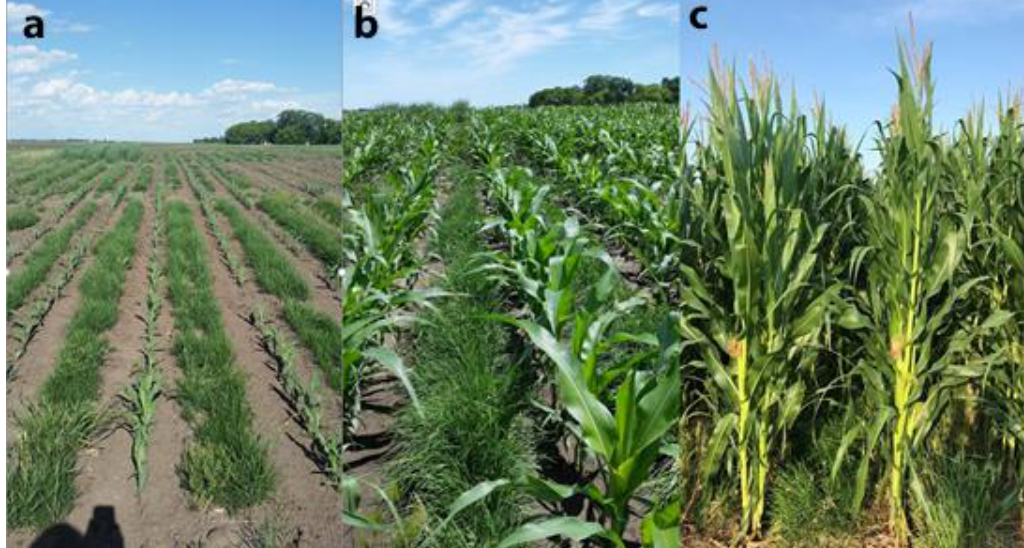
Figure 7. Maize production with Kentucky bluegrass as ground cover (( a ) 31 May, ( b ) 13 June and ( c ) 10 July 2018). Kentucky bluegrass was established in the fall of 2017. A grass-free zone was created in the spring of 2018. Maize hybrid, DeKalb DB57-75RIB (refuge in bag) was planted at 32,000 seeds per acre on 30 April 2018. Maize grown with the Kentucky bluegrass cultivar ‘Shannon’ yielded at least 90% of the grain yield obtained from the non-PGC control plots without using any additional agronomic practices to control interspecific competition.